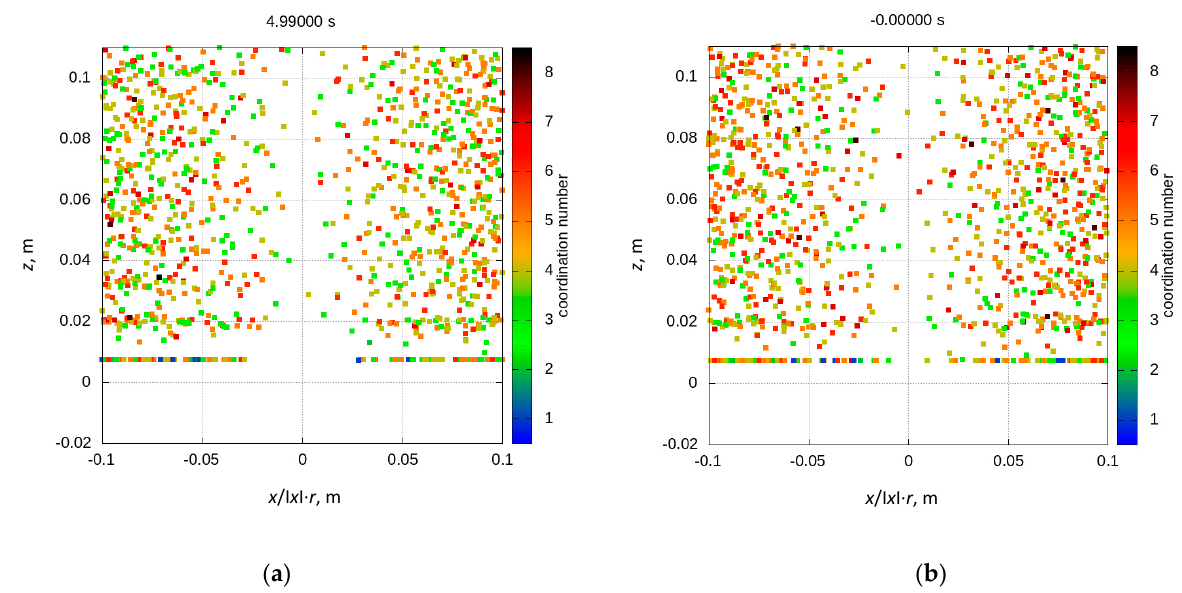
Figure 7. Radial distribution of the coordination number in close proximity of the discharge gate for D 0 = 0.6, µ pp = 0.6, and µ rp = 0, before discharge initiation ( a ) and after clogging ( b ).